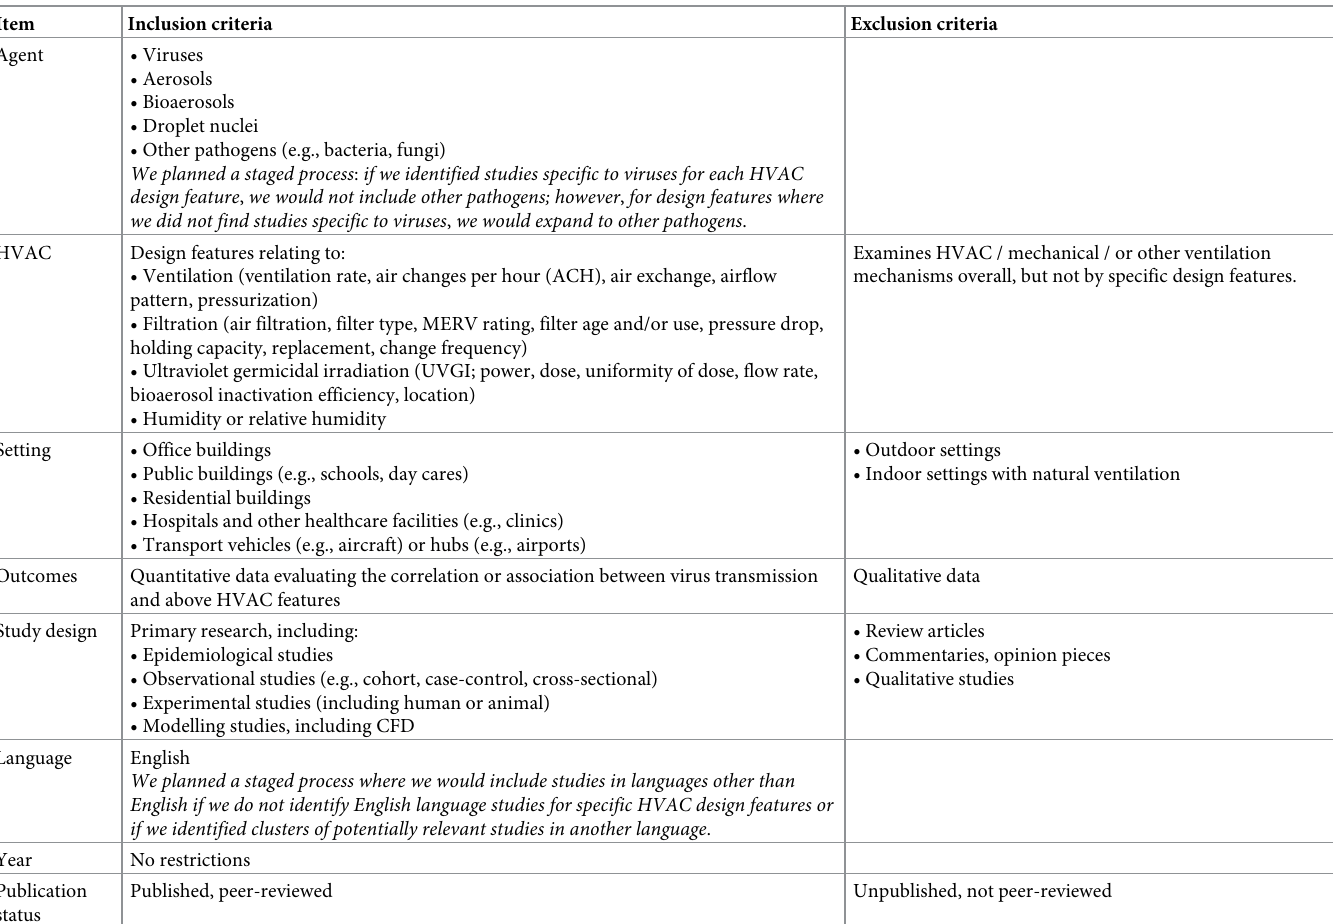
Table 2. Inclusion and exclusion criteria for systematic review